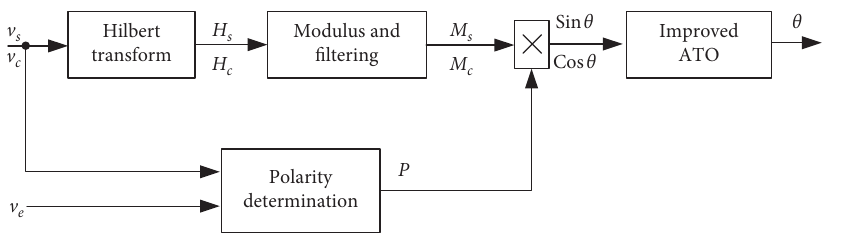
Figure 3: Decoding process diagram.